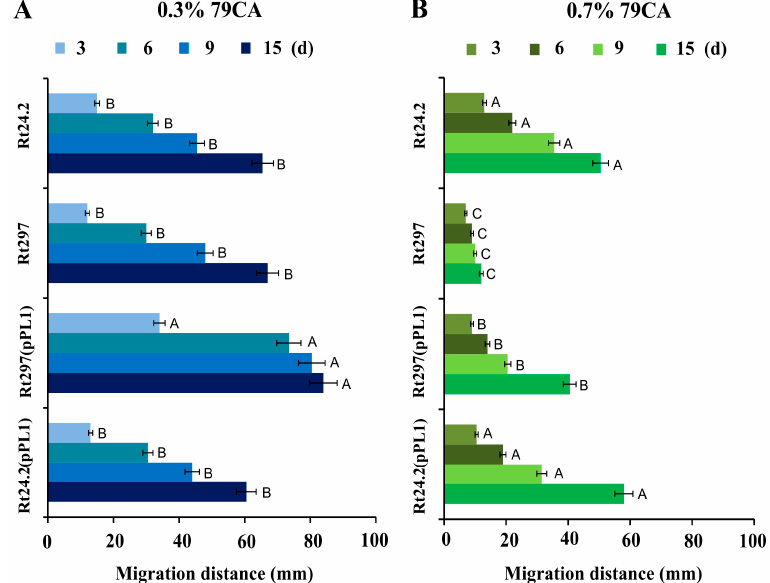
Figure 6. Motility of the wild-type strain R. leguminosarum Rt24.2 and its derivatives tested in 0.3% ( A ) and 0.7% 79CA ( B ) media for 15 d. The given values are averages ± SD of two